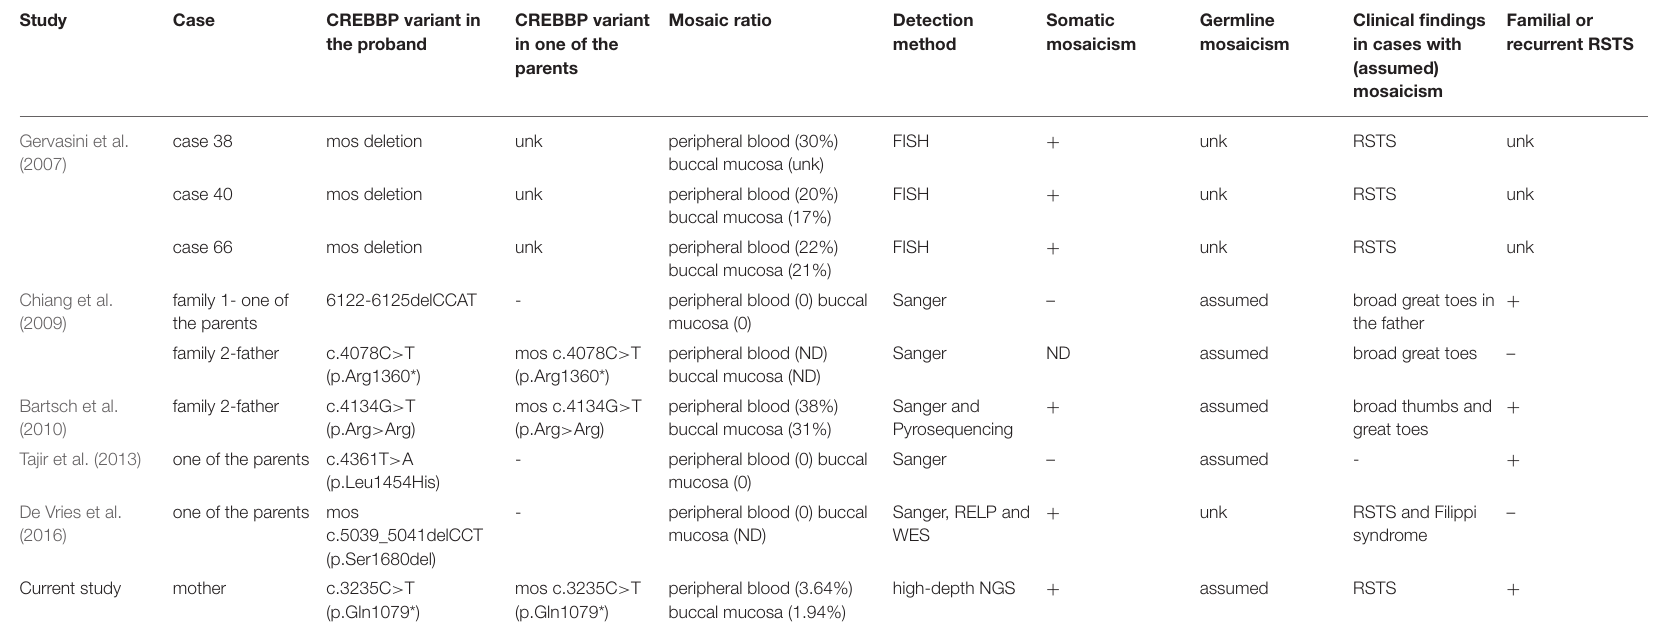
TABLE 2 | Summary of previously reported cases with mosaic variants in